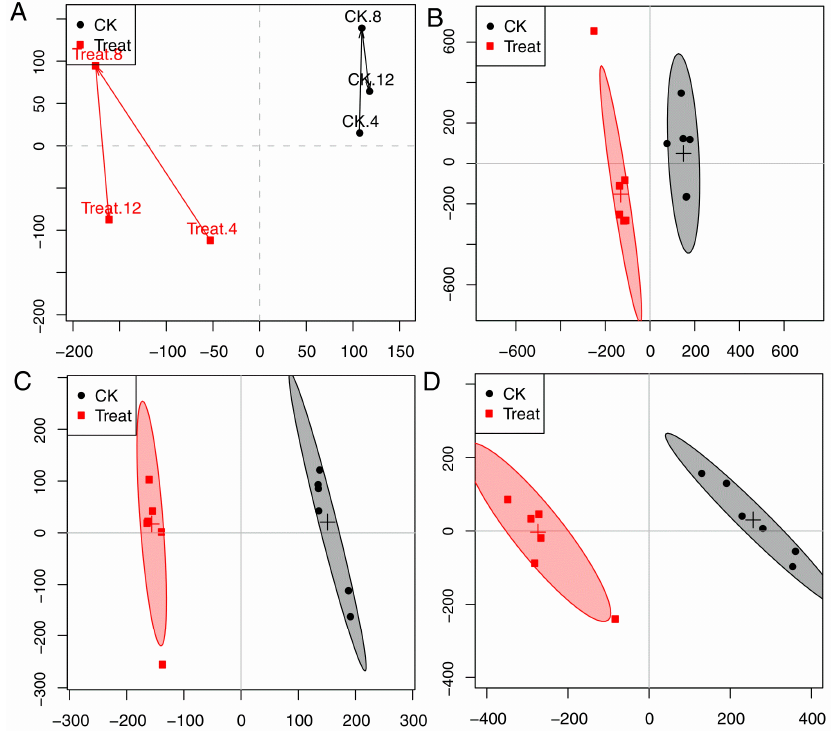
Figure 4. ( A ): Score trajectory plot from OSC-PLS-DA analysis of the CK and treatment groups (4, 8, 12 mean the time periods in hours). ( B – D ): Scores plot of CK and treatment groups in 4, 8, and 12 h, respectively. 12 h,